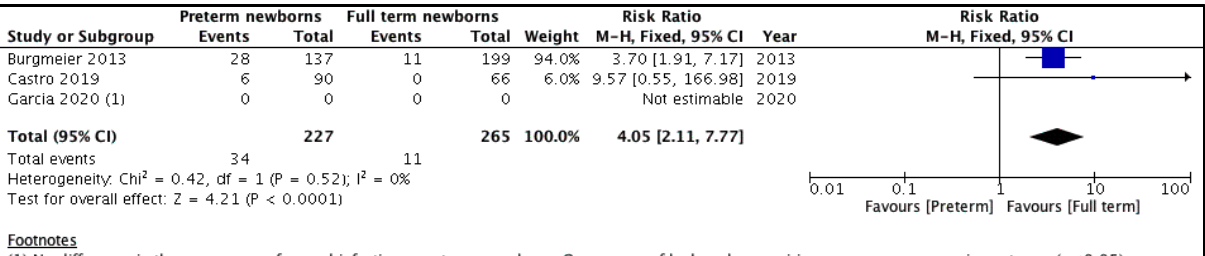
Figure 3. Forest plot comparison between the two patient groups in terms of the postoperative complications .